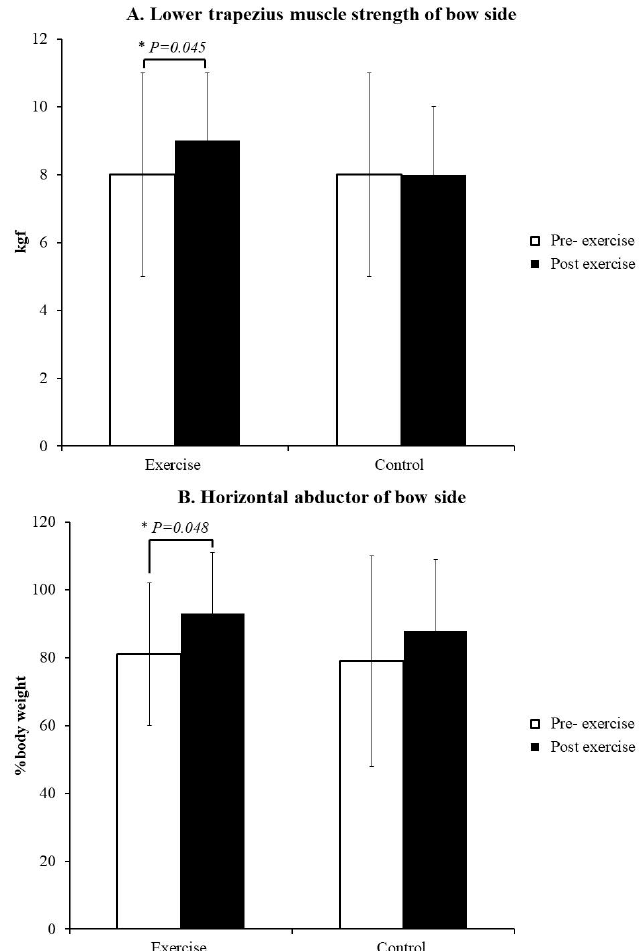
Figure 1. Scores of simulation game. * p ≤ 0.05 between pre- and post-exercise.